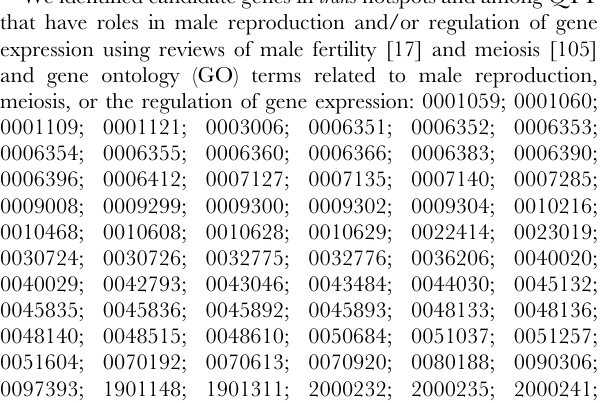
Figure S1 Dominance and effect sizes of eQTL. (A) Proportions of cis and trans eQTL showing additive (add), dominant (dom), underdominant (under) and overdominant (over) effects. (B) Boxplots indicating median (horizontal lines) and interquartile range (boxes) for effects of cis and trans eQTL on the autosomes (auto) and X chromosome, measured by difference in mean expression level (log 2 ) between extreme genotypes. Whiskers indicate 1.5 6 interquartile range. Outliers are shown as points. (TIF) Figure S2 Reduced clustering of trans eQTL mapped in a ‘fertile’ subset of F 2 s and overlap of trans eQTL hotspots and sterility QTL. Graphs indicate the number of trans eQTL mapped to 4-cM sliding windows using the fertile subset (in dark gray) and full data set (blue dashed) for each chromosome. Chromosome numbers are in bold at the bottom left of their respective plots. Dark blue boxes indicate ‘‘ trans hotspots,’’ significantly enriched for trans eQTL. Red boxes indicate positions of sterility QTL identified previously in these mice. Abbreviations indicate phenotype: TW: relative right testis weight, DBT: distal bent tail (sperm morphology), SD: sperm density, H/T: headless/tailless (sperm), ASH: abnormal sperm head morphology, STA: seminif- erous tubule area, TAS: total abnormal sperm, PBT: proximal bent tail (sperm morphology), PC1: sperm head shape principal component 1. Figure S3 Clustering of ‘interaction’ eQTL identified by conditional mapping. The number of trans interaction eQTL for 4 cM sliding windows is plotted across the genome for each conditional mapping analysis. The position of the marker genotype used as a covariate is indicated along the y-axis. Autosomal positions are given as chromosome number, ‘‘.’’, cM position. X-linked markers are given as ‘‘X’’ and cM position. Figure S4 Overlap of interaction eQTL hotspots. Red rectan- gles indicate sterility QTL, with phenotype abbreviations as in Figure S2. Dark blue rectangles indicate trans eQTL hotspots (original mapping). ‘Interaction hotspots’ identified by conditional mapping are shown as ovals above ideograms, color coded and labeled with positions of the marker genotype covariates. Figure S5 X chromosome interactions by region. Interaction network demonstrating distinct patterns for five X genotype covariates in four regions. Nodes/edges in purple involve only the proximal X region and those in green involve the distal X region. Nodes in gray show evidence for interaction with at least one proximal and one distal X covariate. Edge weight indicates the number of interaction eQTL and node size indicates total number of interactions. Table S1 Misexpression of transcripts by spermatogenic cell type. Table S2 X Chromosome